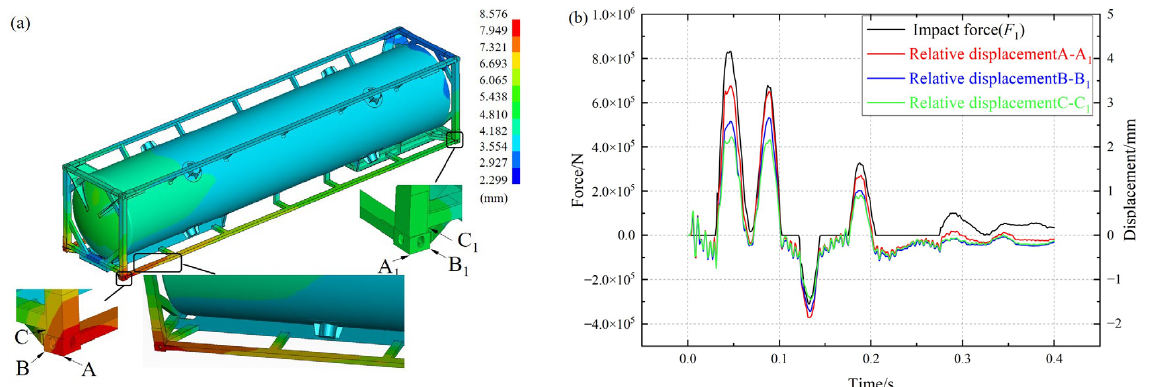
Figure 25. The axial displacement of the frame and outer vessel: ( a ) at the first peak of F 1 , ( b ) relationship with the F 1 .